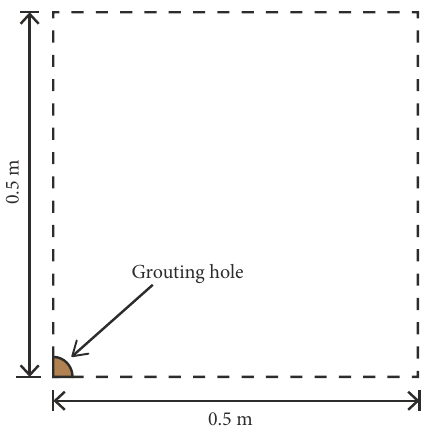
Figure 4: Computational domain of Case